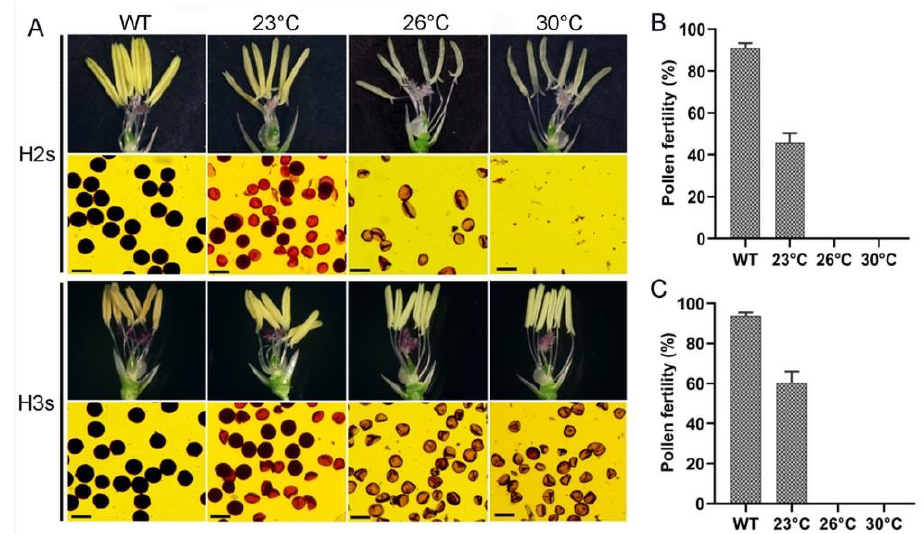
Figure 4. The fertility performance of TGMS lines at different temperatures. H2s and H3s were se- lected from the TMS5 mutants of H2 and H3 lines, respectively. ( A ) Pollen fertility of TGMS lines at different temperatures. H2s and H3s were grown at 23 °C, 26 °C and 30 °C, with light conditions of different temperatures. H2s and H3s were grown at 23 ◦ C, 26 ◦ C and 30 ◦ C, with light conditions 13.5h and dark conditions of 10.5h. ( B ) Pollen fertility of H2s line at different temperatures. ( C ) Pol- of 13.5 h and dark conditions of 10.5 h. ( B ) Pollen fertility of H2s line at different temperatures. len fertility of H3s line at different temperatures. ( C ) Pollen fertility of H3s line at different